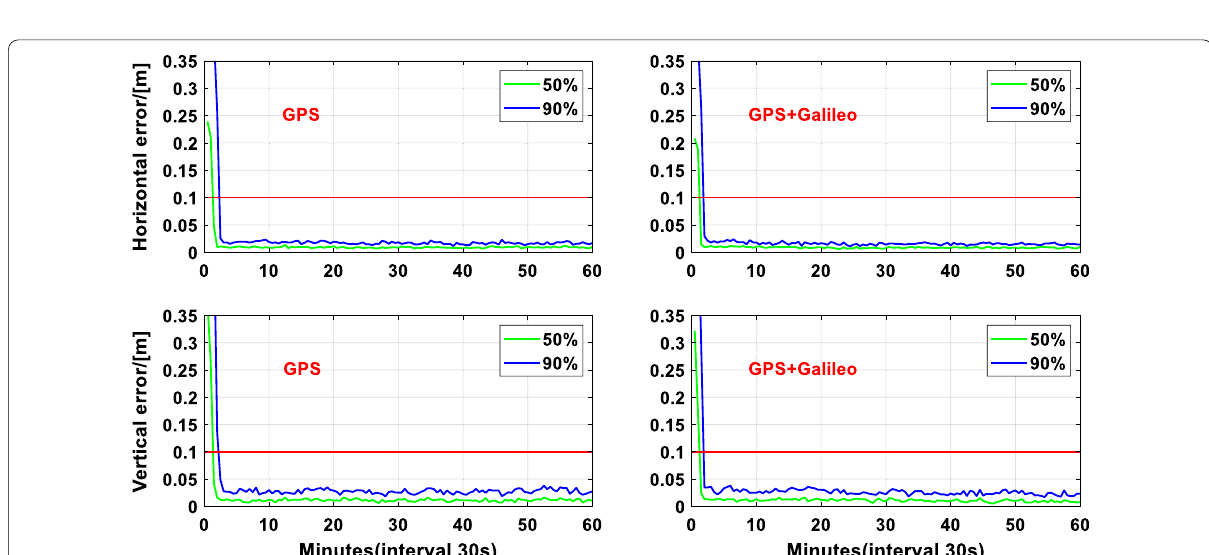
Fig. 13 Convergence performance of PPP-RTK user components for the small-scale network at the 50% and 90% confidence levels. Top panel: horizontal error; bottom panel: vertical error. Left panel: GPS; right panel: GPS